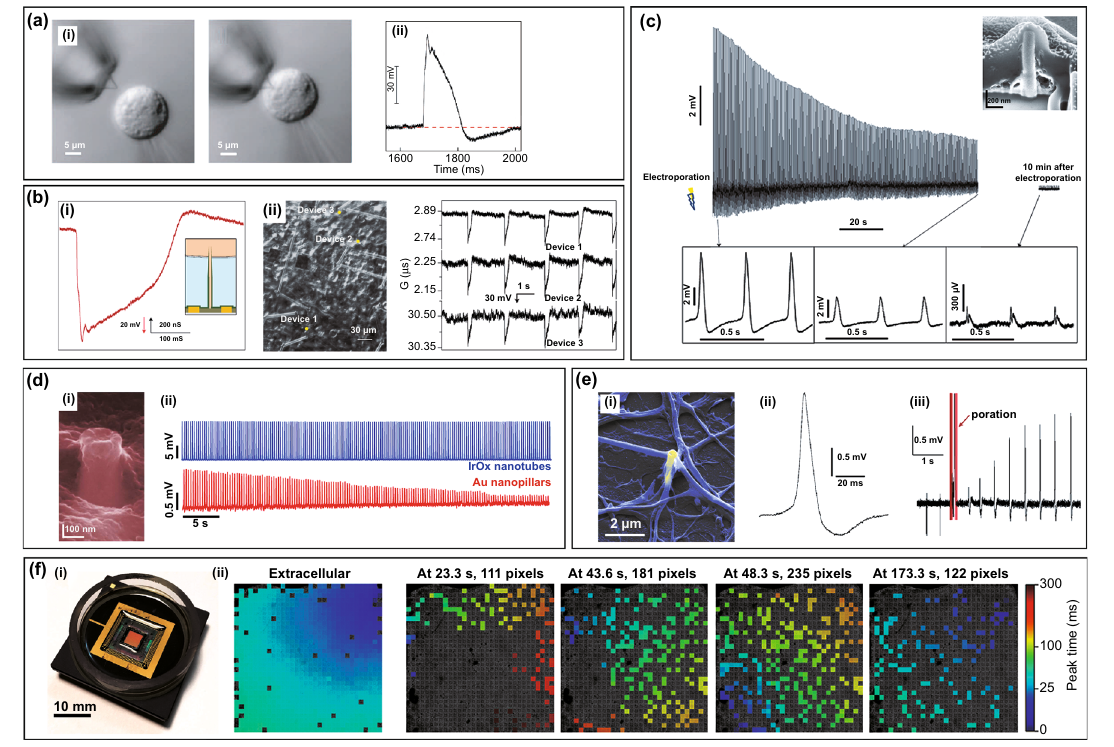
Fig. 5 In-cell nanoelectronics for cardiomyocytes. a (i) HL-1 cell approach, contact and internalized kinked nanowire probe. (ii) Intracellular recording by kinked nanowire FET. Reproduced with permission from Ref. [87]. Copyright 2010, American Association for the Advancement of Science. b (i) Intracellular recording by branched nanotube FET. (ii) Synchronous intracellular recording by three BIT-FET devices. Repro- duced with permission from Ref. [102]. Copyright 2011, Nature. c Intracellular recording by nanopillar electrodes. The amplitude decays within 10 min after electroporation. The inserted image (upper right) shows the nanopillar electrode being fully engulfed by the cell. Reproduced with permission from Ref. [91]. Copyright 2012, Nature. d (i) IrOx nanotube device engulfed by cardiomyocytes. (ii) Intracellular recording by IrOx nanotube electrodes. The action potential remained stable within 1 min compared with Au nanopillar electrodes. Reproduced with permission from Ref. [101]. Copyright 2014, Nature. e (i) Gold plasmonic 3D nanoelectrodes enveloped by cell. (ii) Intracellular recording by nanoelec- trodes after plasmonic optoporation. (iii) The gradually increased amplitude of action potentials within the first 2 s after plasmonic optoporation. Reproduced with permission from Ref. [100]. Copyright 2017, American Chemical Society. f (i) The device of nanodevices combining with CMOS circuit. (ii) The spatial propagation of action potentials before and after electroporation. Reproduced with permission from Ref. [92]. Copyright 2017,